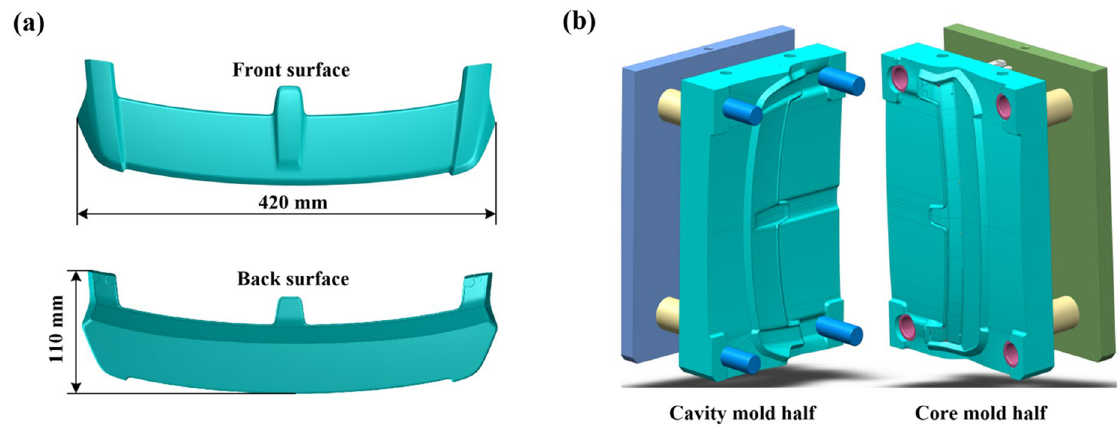
Fig. 8 Schematic of ( a ) automotive spoiler (Material: ABS, Wall thickness: 2 mm) and ( b ) corresponding blow